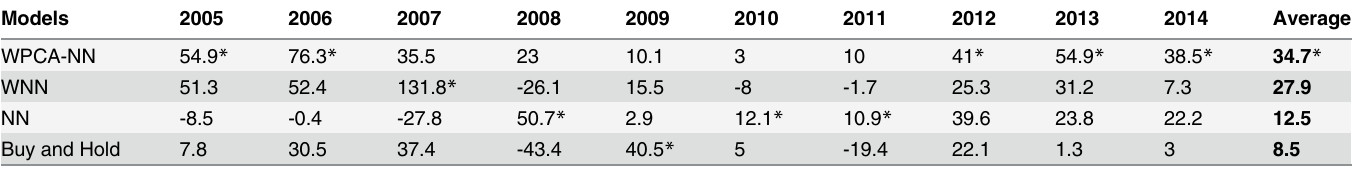
Table 4. Return of the models, results for HANG SENG futures. Models